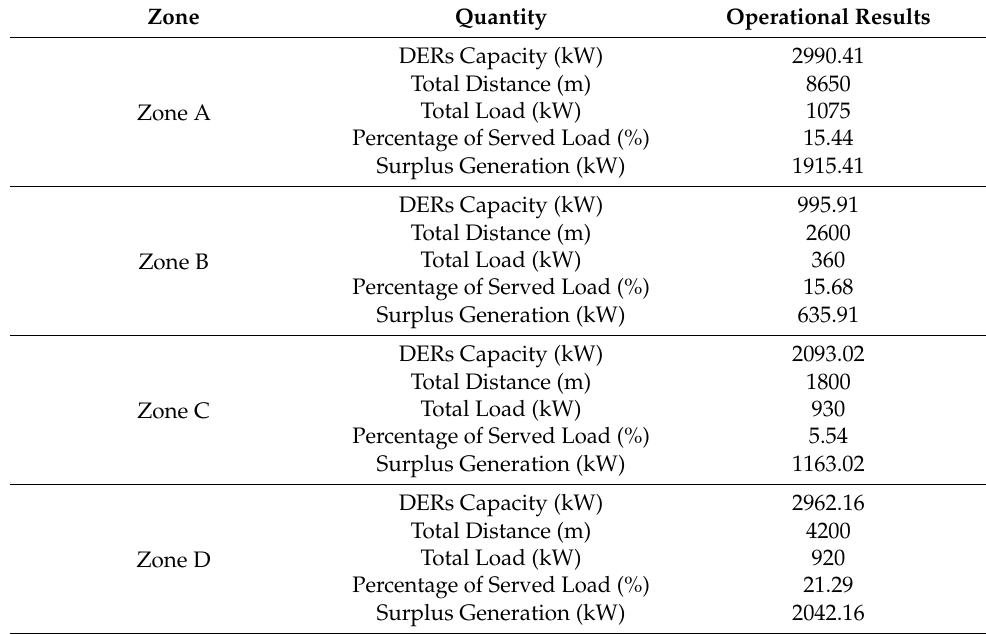
Table 3. Optimal Operational Results in Case